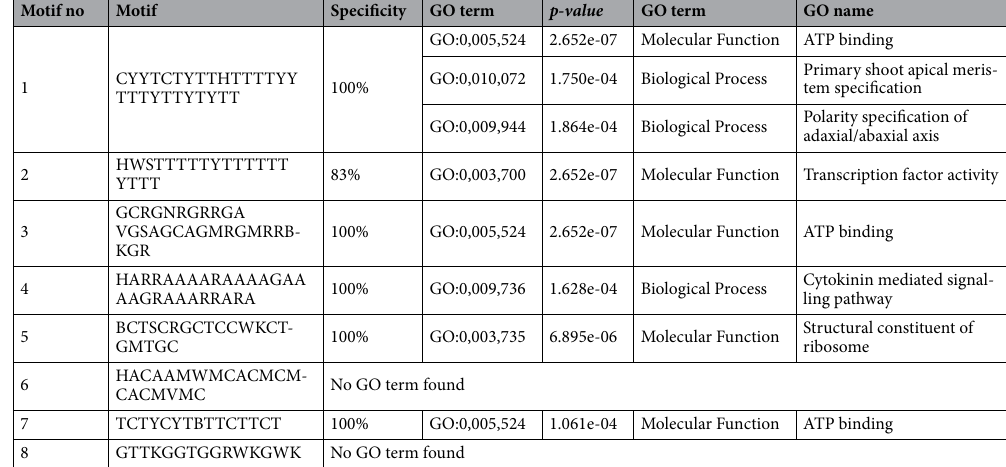
Table 2. List of eight motifs identified in cucumber